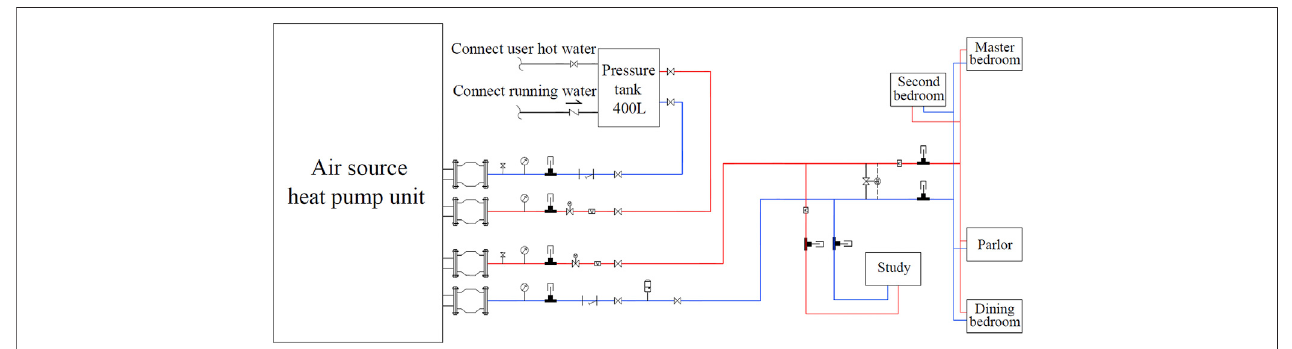
FIGURE 5 | Experimental test system diagram.